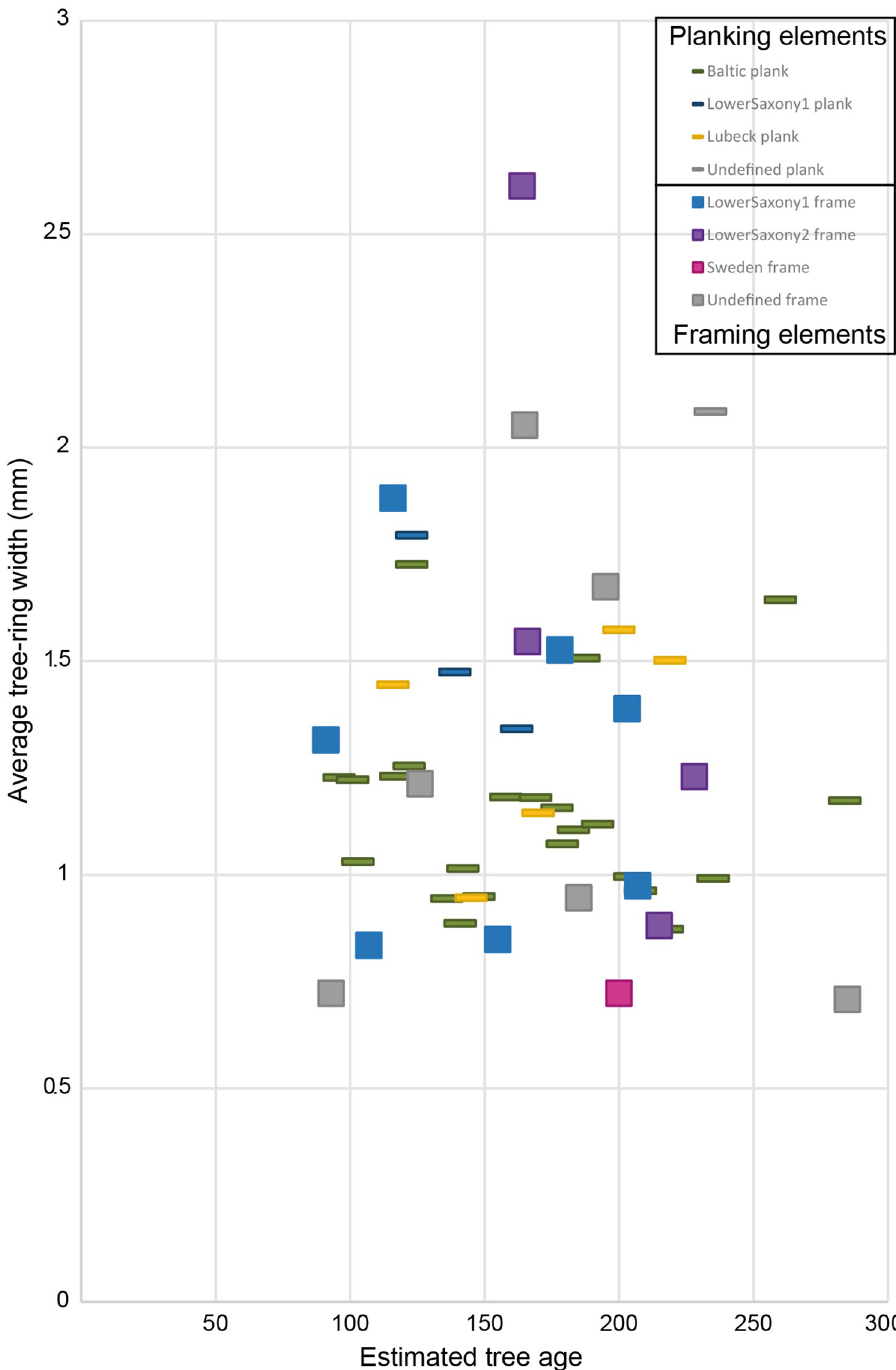
Fig 4. Growth rates (mean ring width) and tree ages per provenance and type of timber. Growth rates of framing and planking elements vary similarly (hence no discriminant selection of trees has been made for specific timber elements), but timber elements show a distinct discrimination based on geographical area (framing elements were obtained primarily from the Lower Saxony in north-west Germany, while planks were mainly obtained from the Baltic and Lu¨beck area). The tree ages have been estimated considering that all the trees from the dated timbers were cut in 1625. Since the pith is absent in all the samples, some trees might be older than estimated.